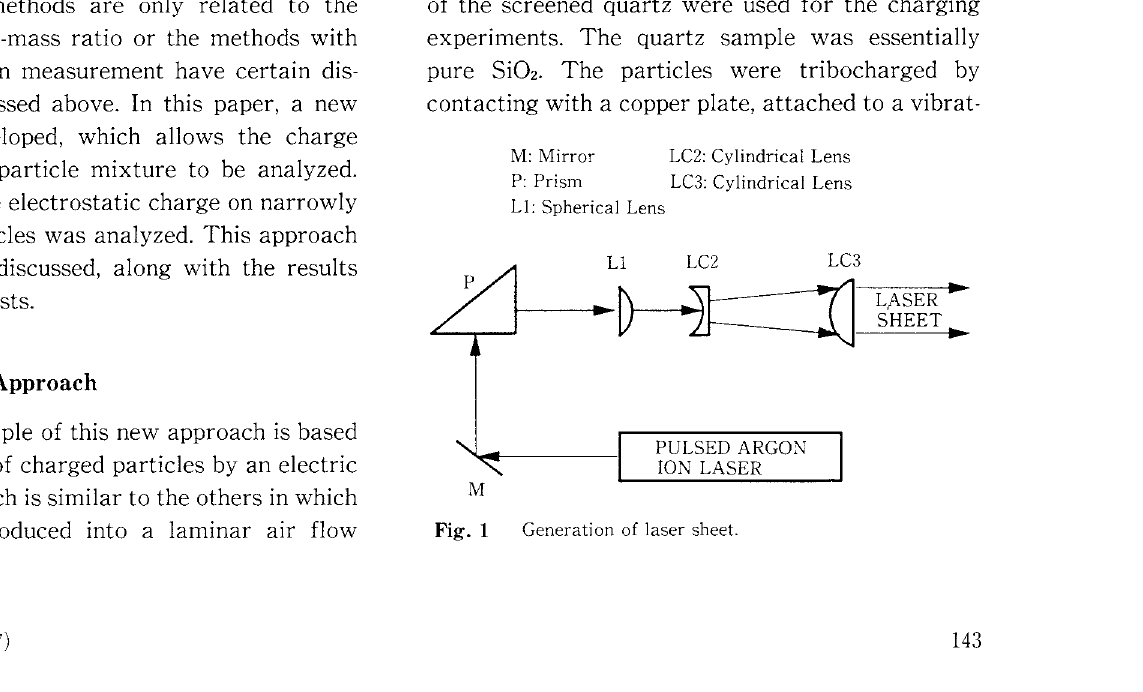
Generation of laser